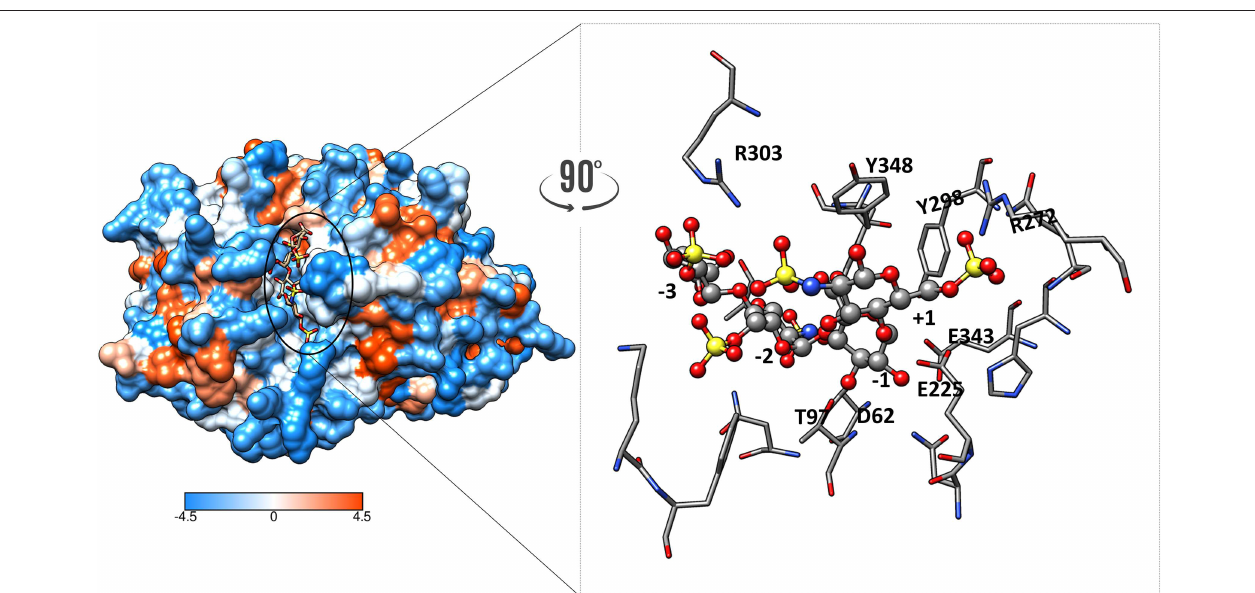
FIGURE 2 | Hydrophobic surface of heparanase showing heparin tetrasaccharide in the catalytic cleft. The orange color indicates hydrophobicity whereas the blue show hydrophilic surfaces. Zoom-in view of the catalytic cleft in complex with the heparin tetrasaccharide substrate showing interactions at various subsites. Hydrogens are not shown for